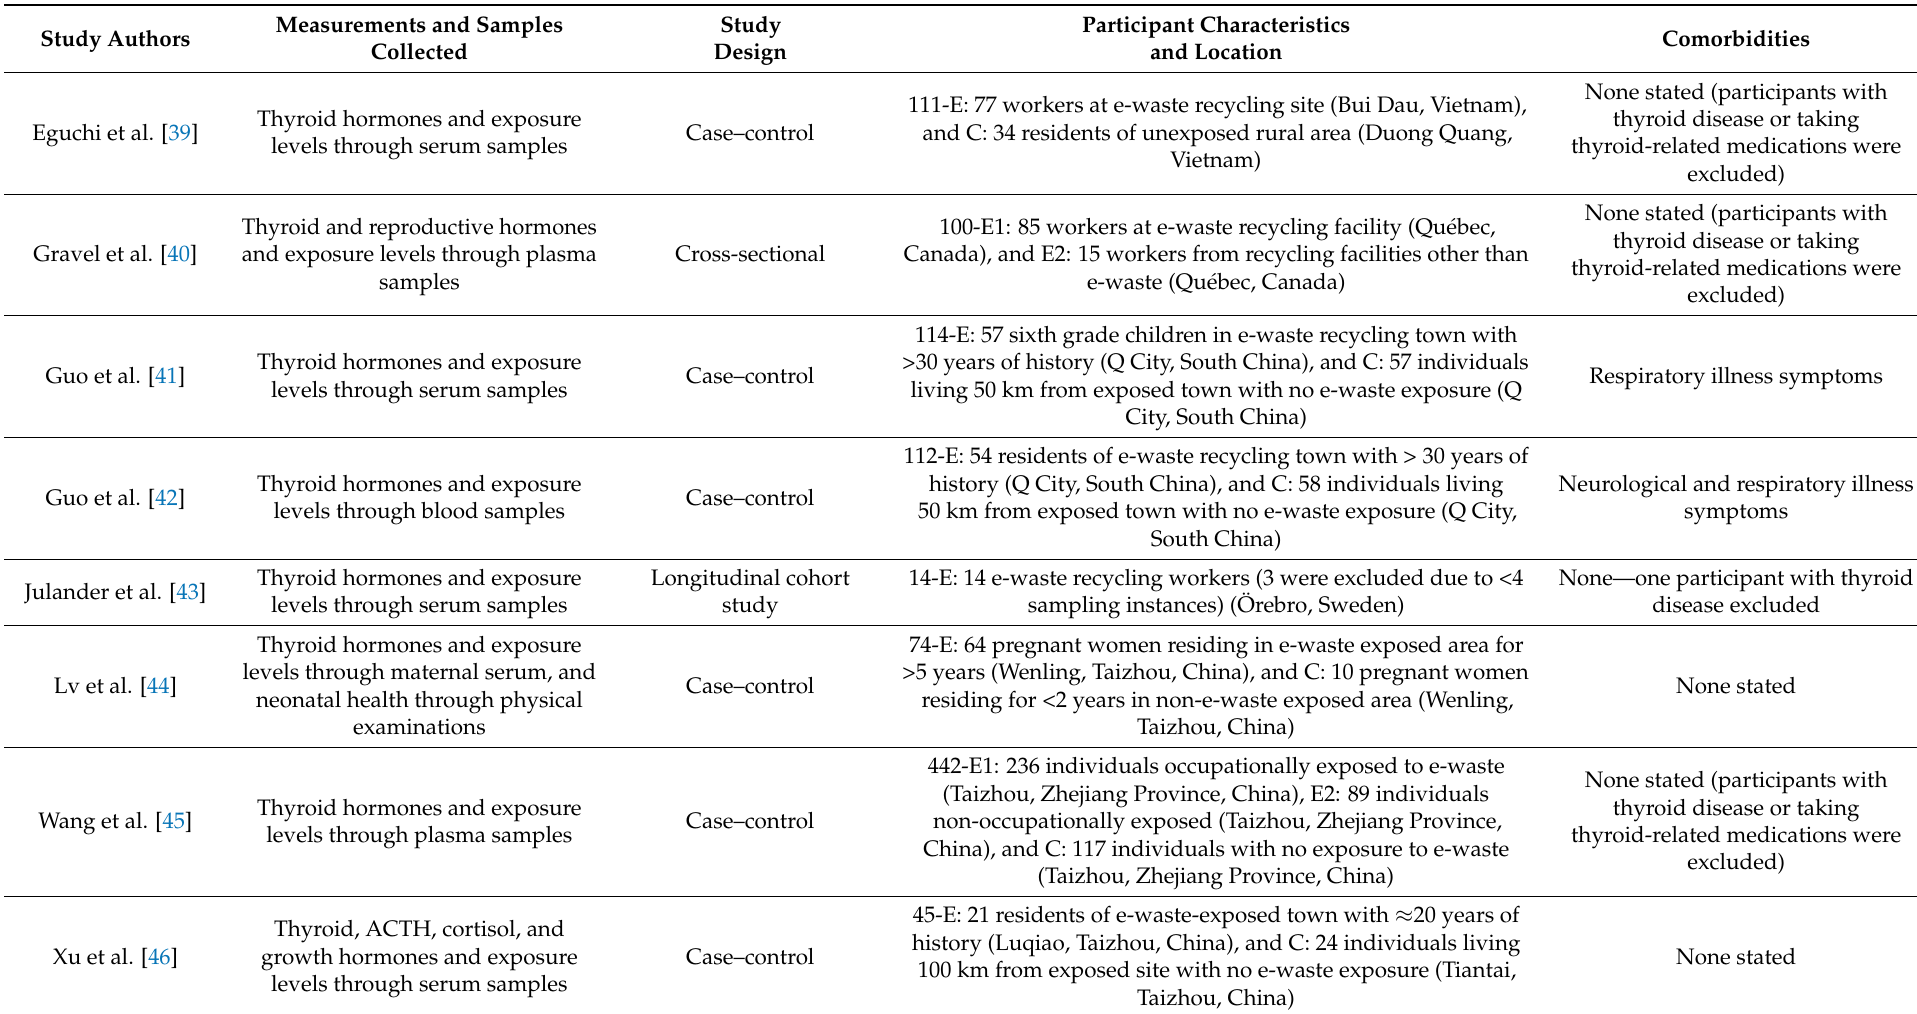
Table 1. Characteristics of the studies selected in the